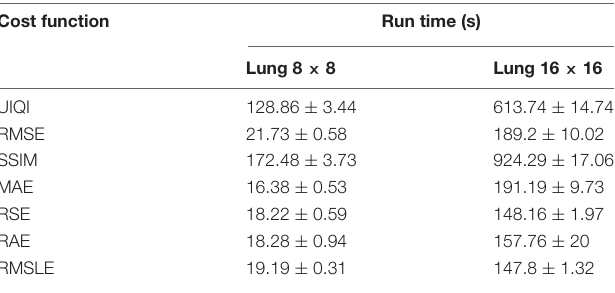
TABLE 4 | Comparison of execution times for numerous cost functions for 8 × 8 and 16 × 16 lung